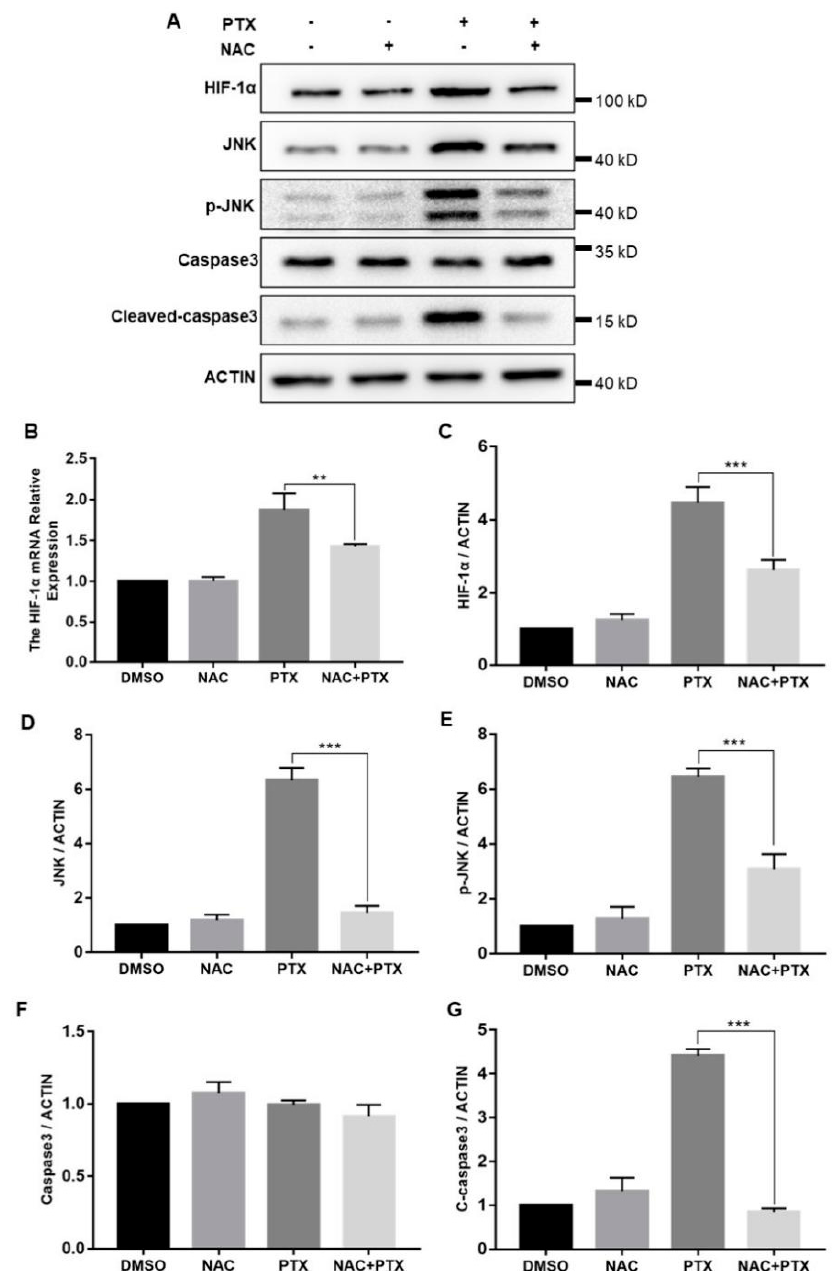
Figure 6. The expression of HIF-1 α , JNK, P-JNK, caspase3, cleaved-caspase3 and actin in the PC3M cells were detected following the treatment with paclitaxel with or without NAC. ( A ) Representative Western blot showing the protein expression of HIF-1 α , JNK, P-JNK, caspase3, cleaved-caspase3 and actin. ( B ) mRNA expression of HIF-1 α was determined by real-time qPCR after the treatment with paclitaxel in presence or absence of NAC. ( C – G ) Summarized data of immunoblotting mentioned above. Results are expressed as mean ± SD, n = 3. **: p < 0.05, ***: p < 0.001.